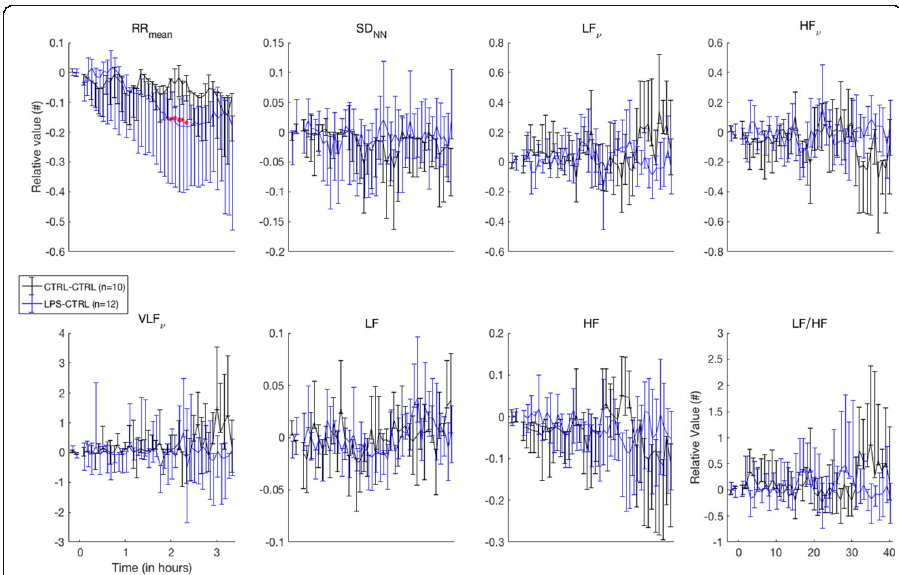
Fig. 6 Temporal and spectral evolution in LPS-CTRL/CTRL-CTRL groups. LPS injection was not associated with any change in temporal and spectral